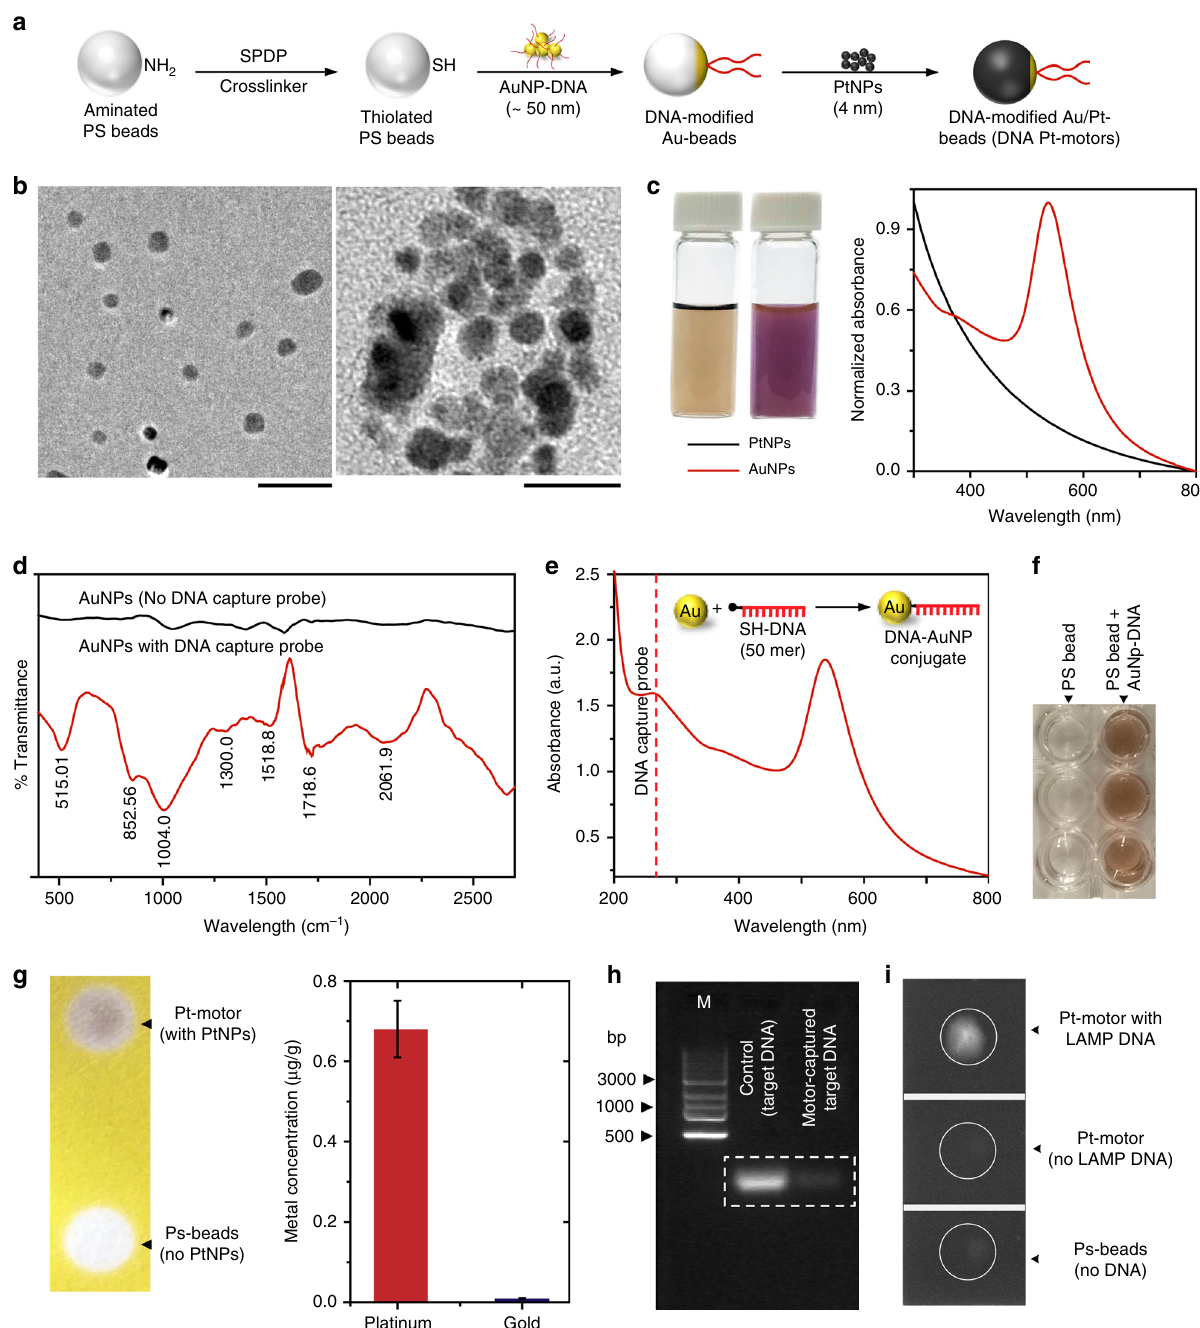
Fig. 2 Pt-motor preparation and characterization. a Schematic of motor preparation reaction. Polystyrene (PS) beads that carry amine groups on its surface are initially activated with excess of succinimidyl 3-(2-pyridyldithio)propionate (SPDP) crosslinker to prepare thiolated (-SH) beads. Then gold nanoparticles (AuNPs) modi fi ed with DNA capture probe (30-mer in size) and platinum nanoparticles (PtNPs) are added to the surface of thiolated beads